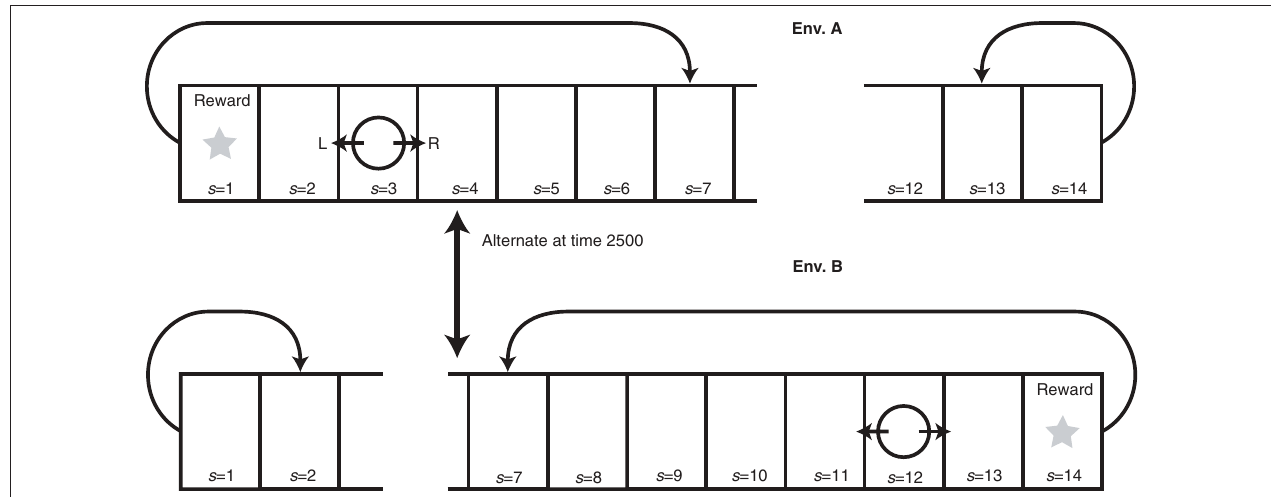
unrewarded terminal, it is moved one position back (from s = 14 to s = 13 in Env. B and from s = 1 to s = 2 in Env. A). Each of the model’s two modules becomes specialized by modular RL to maximize the agent’s accumulated reward in one of the two versions of the environment (Env. A and Env. B) defined by